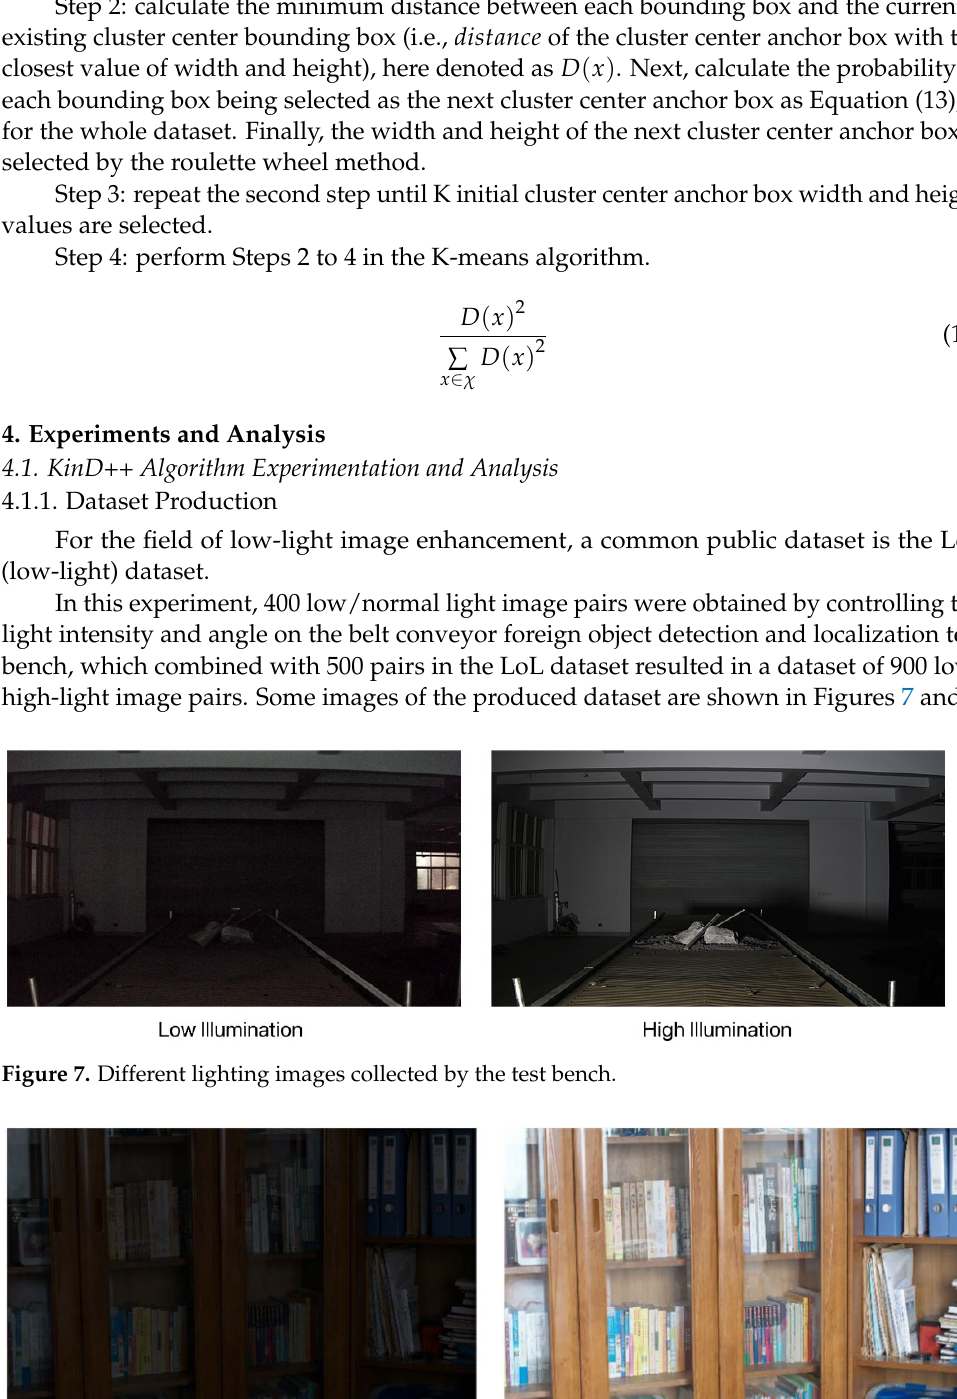
Sensors 2022 , 22 , x FOR PEER REVIEW